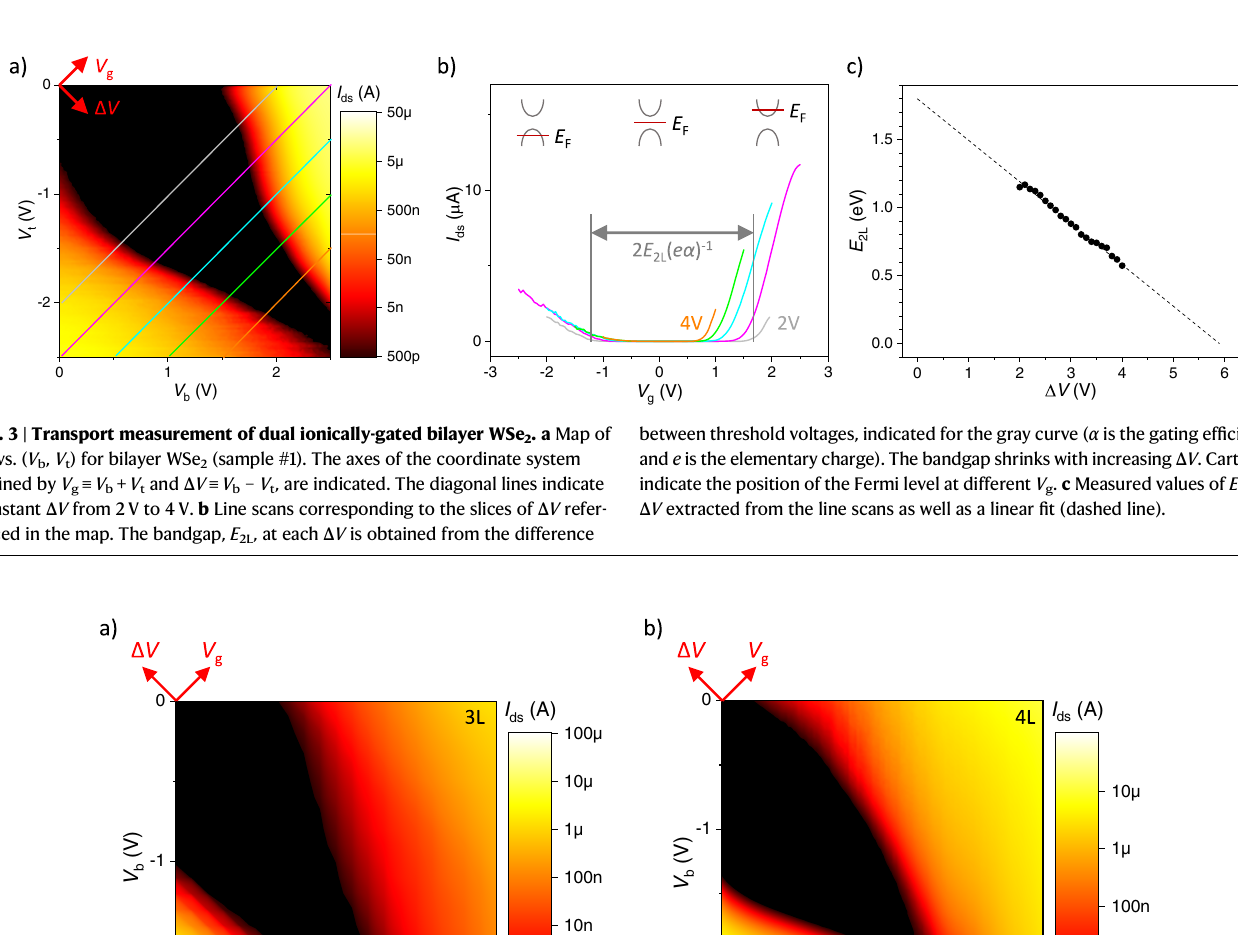
Fig.2|Deviceandmeasurement overview.a Side-viewcartoonofthedeviceand measurement scheme. The 2Dmaterial (2DM) is suspendedover a holein a silicon nitride (SiN) membrane grown on a silicon (Si) substrate. Gold (Au) electrodes are used to electrically contact the device, and cross-linked PMMA resist covers the drain/source electrodes. All voltages are de fi ned as in Fig. 1. b Microscope (5x) image of sample #1 before applying ionic liquids. Drain and source electrodes are